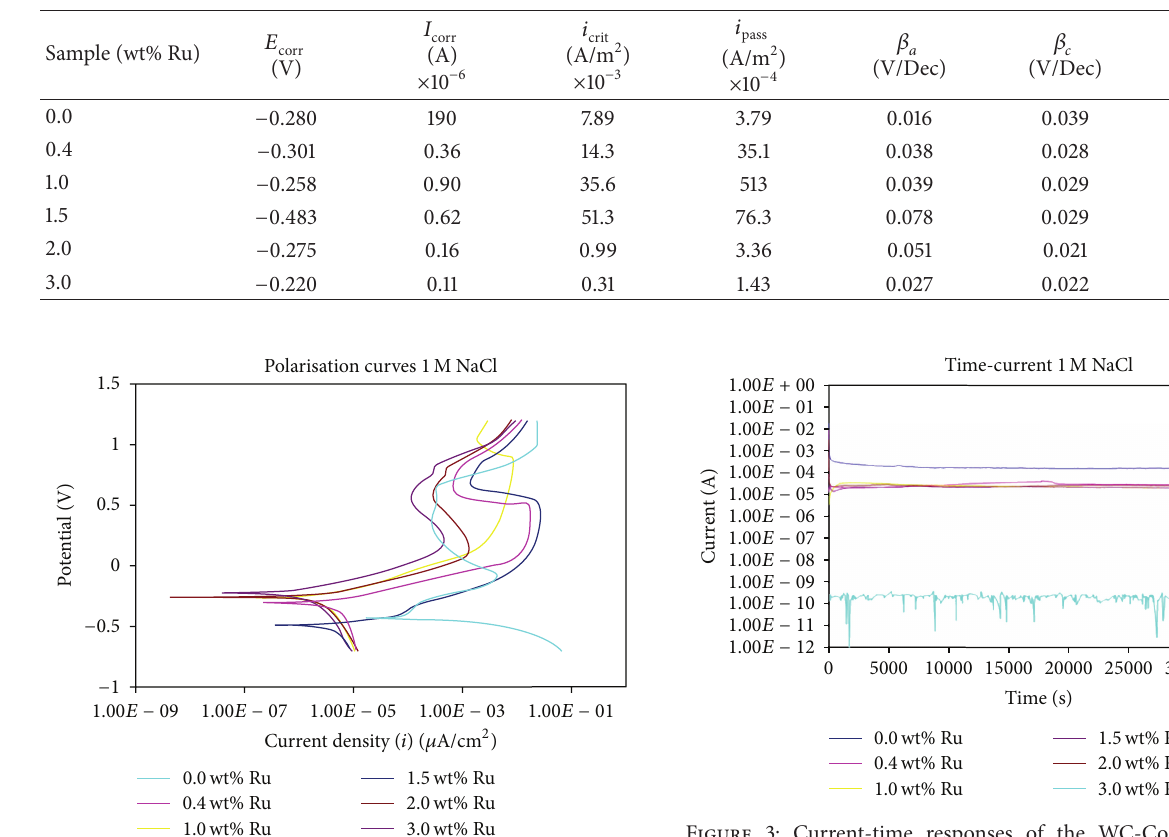
Table 3: Electrochemical parameters for the investigated alloys in 1M sodium chloride.